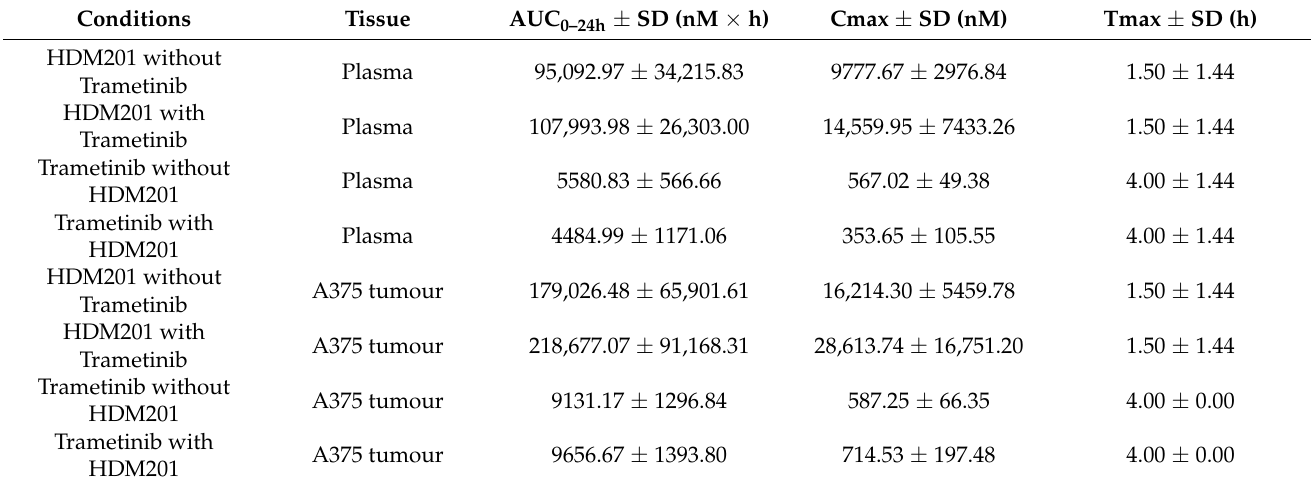
Table 6. Calculated PK parameters for HDM201 and Trametinib in plasma and A375 tumour tissue.